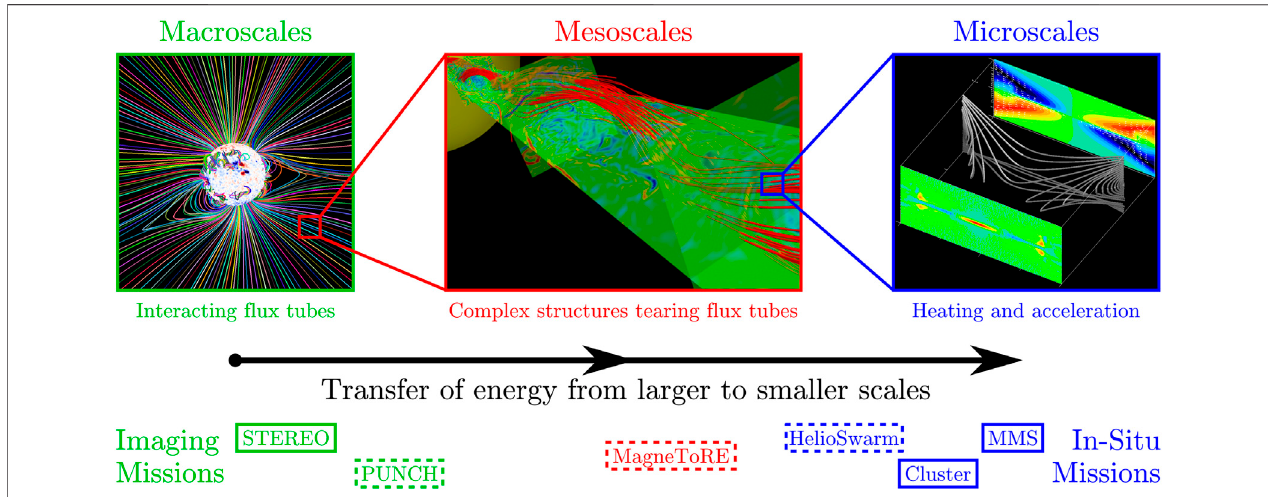
FIGURE 1 | Representationofthethreeprimarysizescalesintheinterplanetarymagnetic fi eld(IMF).Theapproximatescalesexploredbyselectpast/present(solid)andfuture (dashed) missions are also indicated. Left image: prediction of the solar corona ’ s magnetic fi eld during the 21 August 2017 total solar eclipse performed by the team at Predictive Science, Inc., San Diego, CA, United States (Miki´c et al., 2018). Center image: rendering of magnetic- fi eld lines from simulations of re fl ection-driven Alfvén-wave turbulence inside a narrow magnetic fl ux tube (Jean C. Perez, Florida Institute of Technology). Right image: simulation of a magnetic reconnection region by Zenitani et al. (2011).